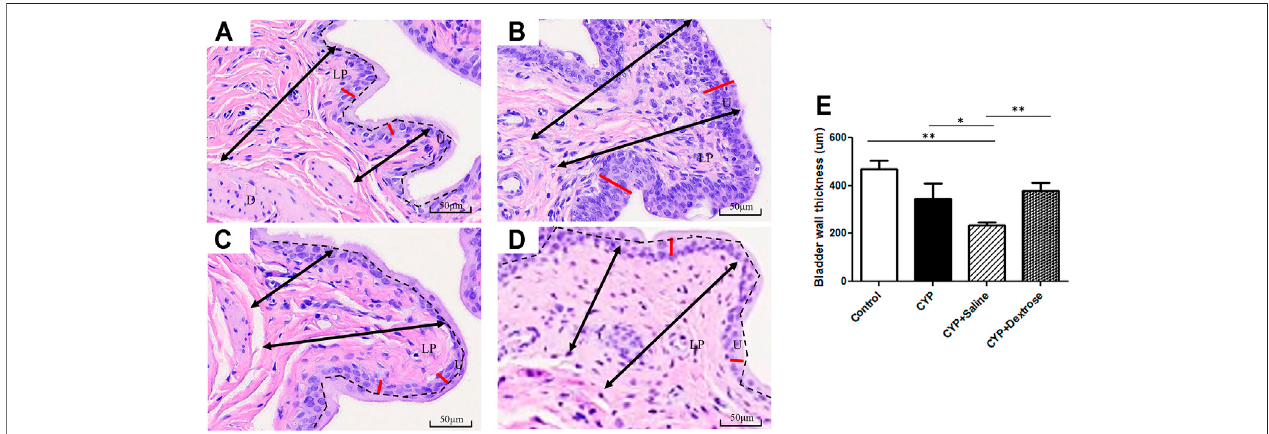
FIGURE 3 | Hematoxylin and eosin staining of bladder tissues in interstitial cystitis rat model. (A) Normal control group; (B) CYP group; (C) CYP-saline group; (D) CYP-dextrose group; (E) Quantitative analysis of the bladder wall thickness. (D (cid:1) detrusor; LP (cid:1) lamina propria; U (cid:1) urothelium; black arrow (cid:1) the range of bladder wall; red line (cid:1) the urothelium; black dash (cid:1) the separation of glycosaminoglycan layer and urothelium; * p ≤ 0.05; ** p ≤